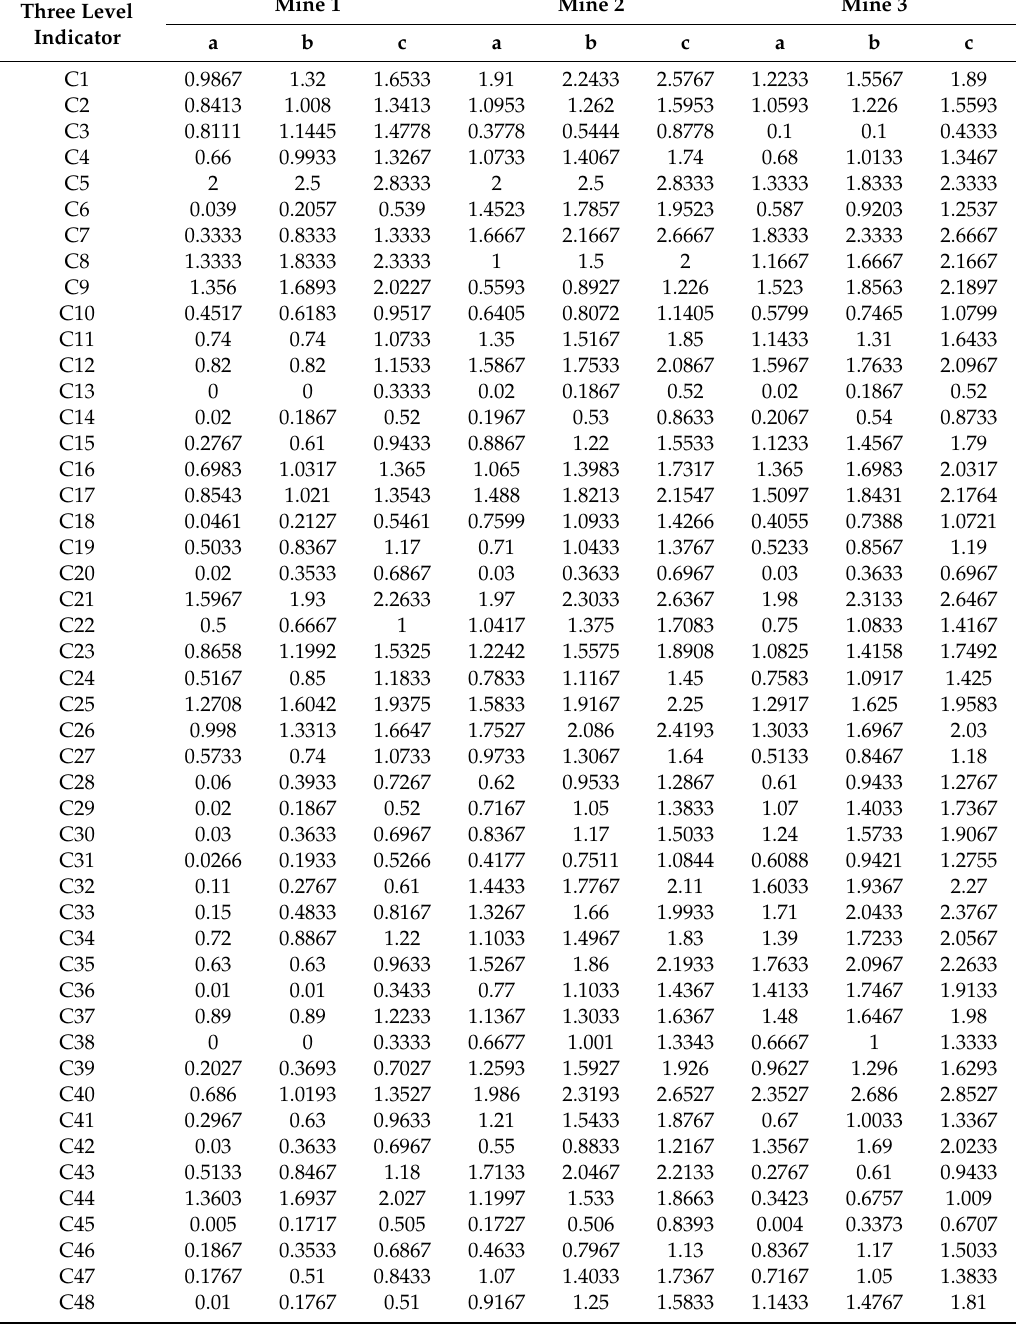
Table 2. Risk values scored by experts represented as triangular fuzzy